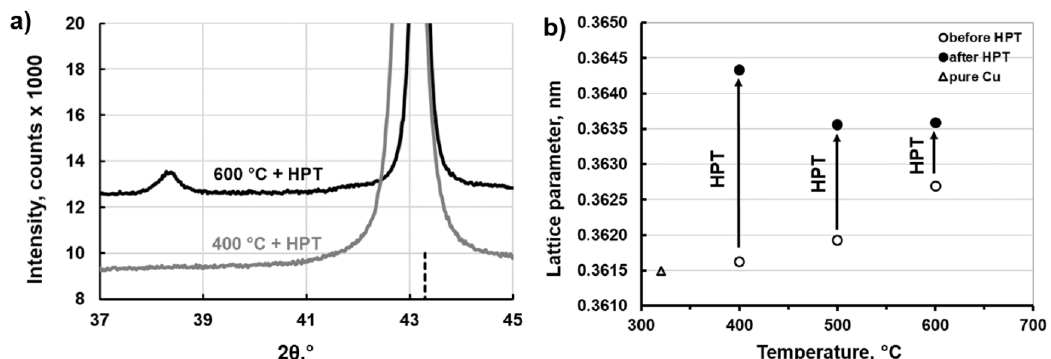
Figure 6. ( a ) Enlarged part of X-ray diffraction patterns of samples of the Cu–8wt.%Ag alloy after HPT and preliminary annealed at 400 and 600 °C. Vertical dotted line shows the (111) peak position of pure copper; ( b ) Changes of lattice parameter of Cu-matrix induced by HPT in samples preliminarily annealed at 400, 500 and 600 °C.